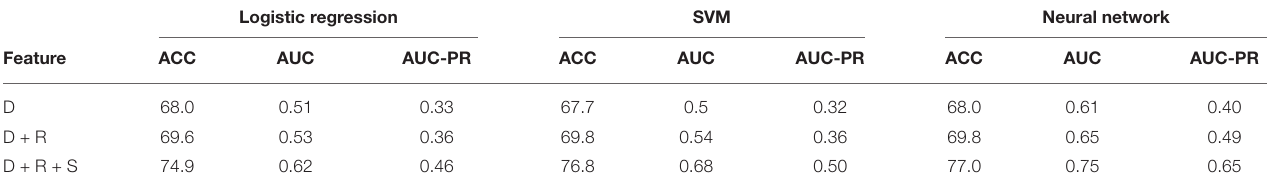
Logistic regression SVM Neural